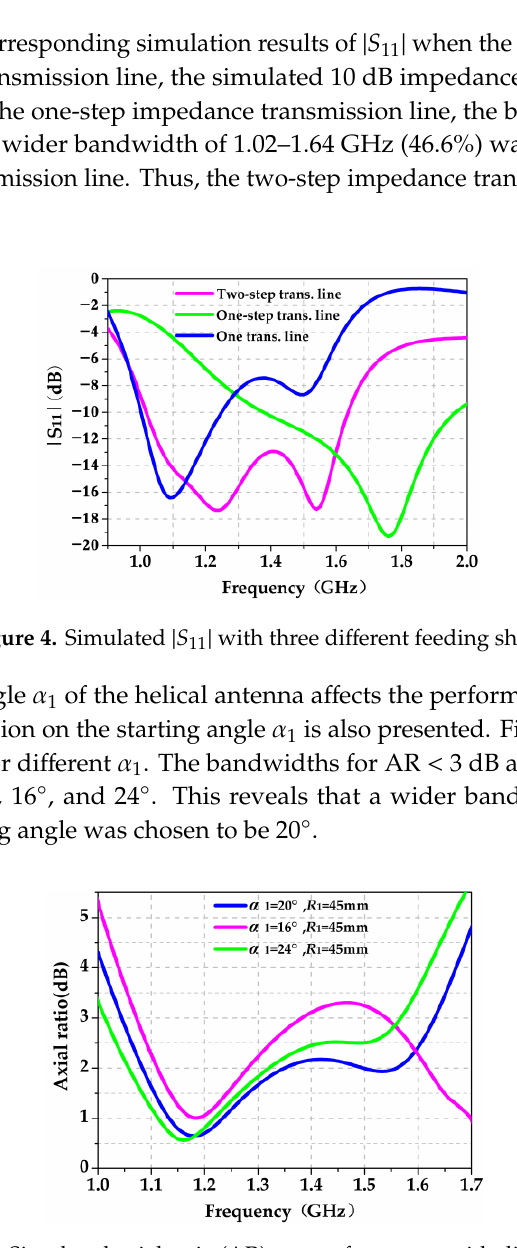
( b ) Figure 6. Simulation and measurement results for State-I: ( a ) | S 11 |; ( b ) AR and gain.